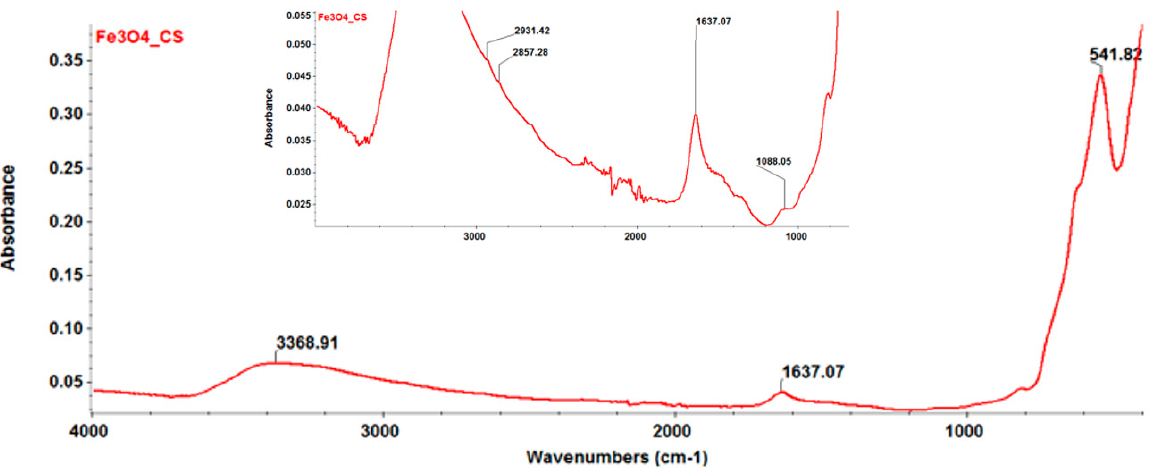
Figure 3. FT-IR spectrum of Fe 3 O 4 @CS nanoparticles.